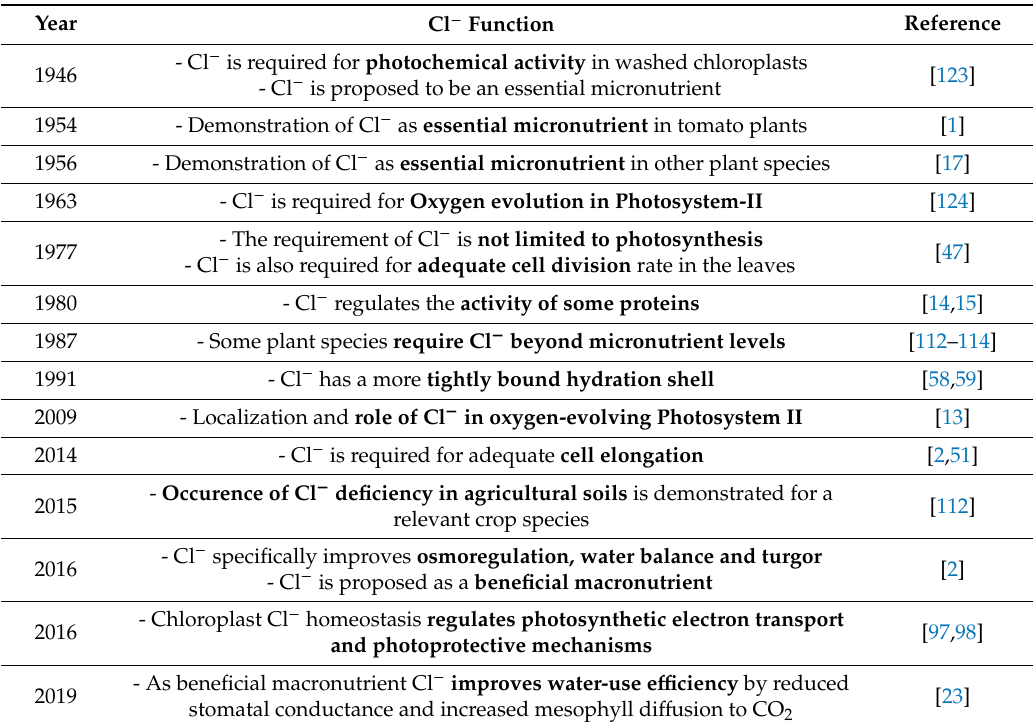
Table 2. Major breakthrough regarding Cl − function research in